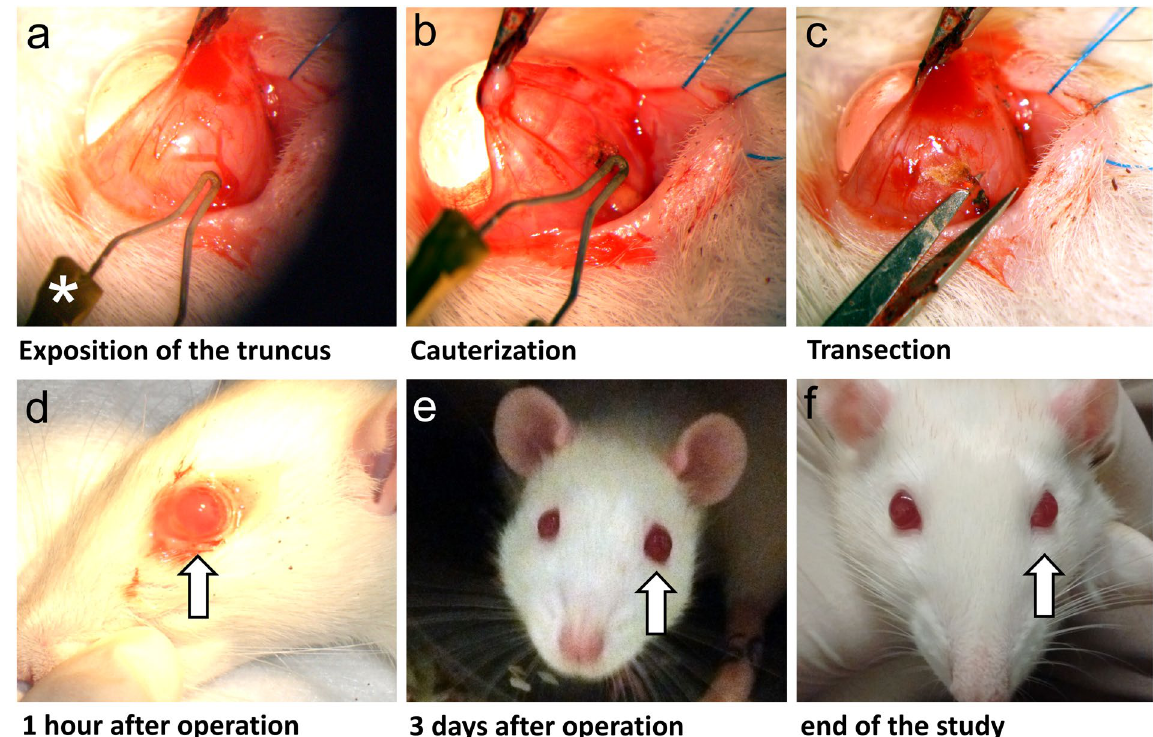
Figure 9. The occlusion of episcleral veins by cauterization and full recovery of the eye after operation. Representative figures of the cauterization of episcleral veins show the exposition of the truncus ( a ) after incision of the conjunctiva and the cauter ( * ). The venous truncus was cauterized with great attention not to damage surrounding tissue ( b ) and remaining tissue was transected using a scissor ( c ). Recovery from the operation occurred rather fast as shown after 1 hour ( d ), 3 days ( e ) and at the end of the study ( f